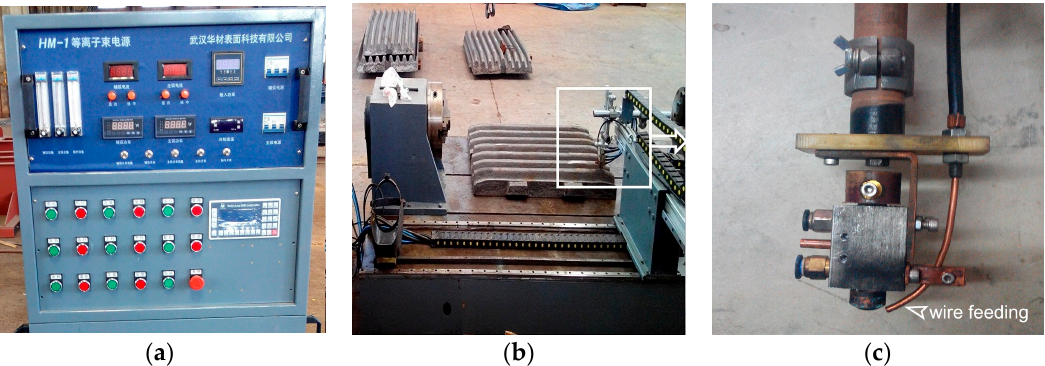
Figure 2. PTA cladding equipment: ( a ) Plasma power source and CNC controller; ( b ) Worktable; ( c ) Plasma torch.